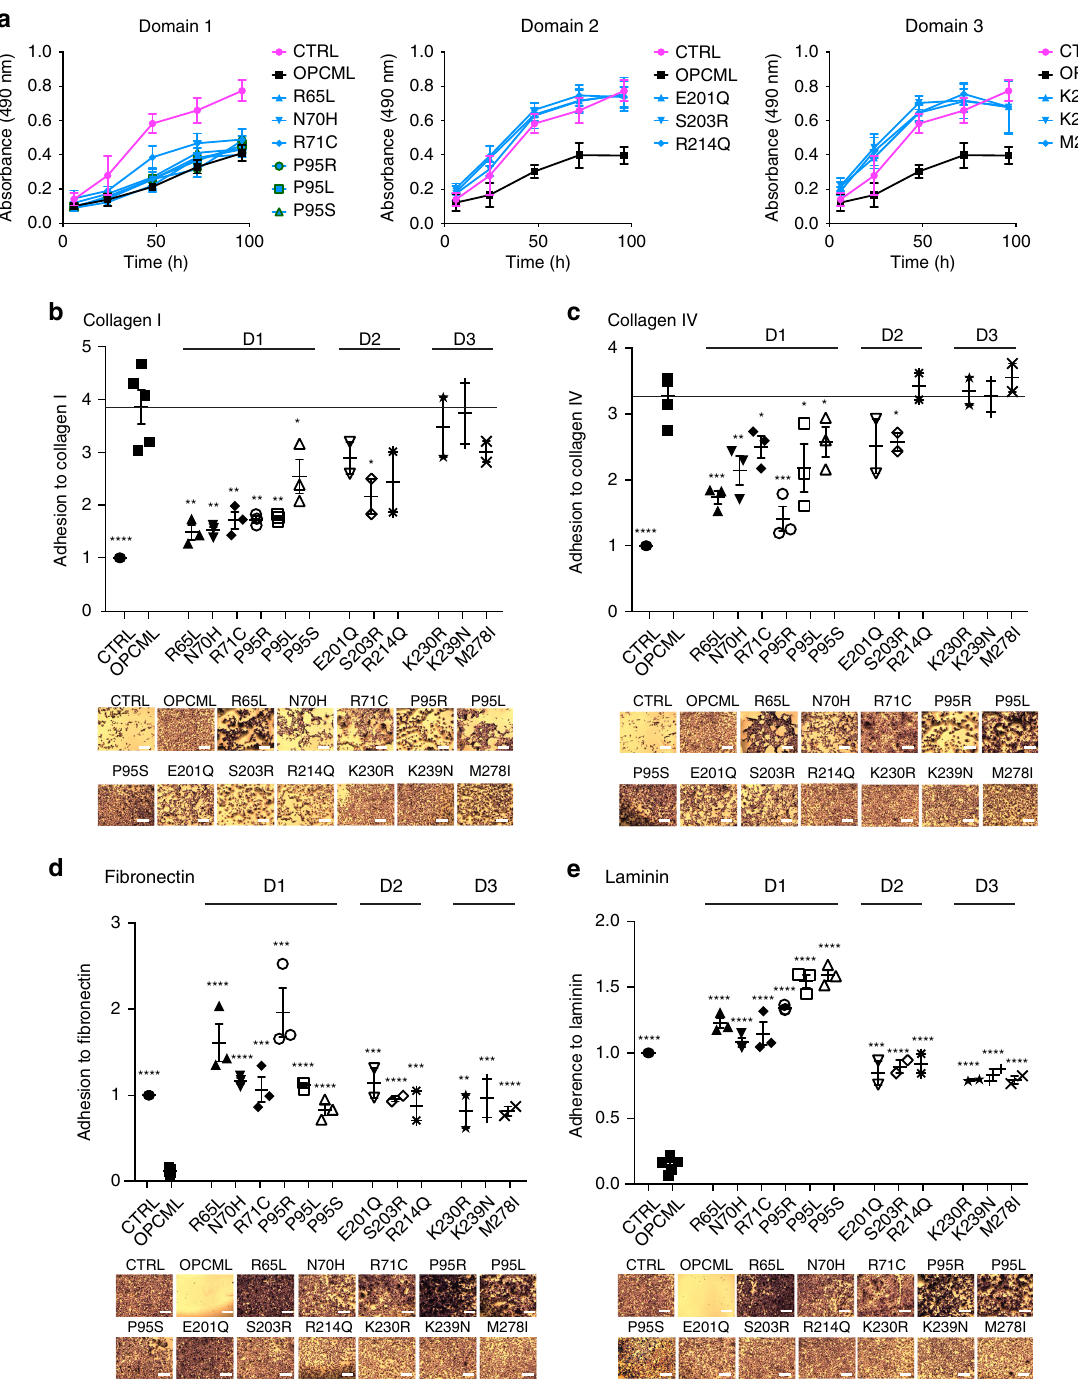
Fig. 7 Different domains mediate distinct functions. a SKOV3 cells transduced with an empty vector (CTRL), wild-type (OPCML) or mutant (R65L, N70H, R71C, P95R, P95L, P95S in D1 in the left panel, E201Q, S203R, R214Q in D2 in the central panel, K230R, K239N, M278I in D3 in the right panel) OPCML were analyzed for proliferation. CTRL cells are represented in magenta, wild-type OPCML in black and the mutants in light blue. All the graphs show the mean ± s.d. of four independent experiments. b – e The different cell lines were plated onto collagen I ( b ), collagen IV ( c ), fi bronectin ( d ) or laminin ( e ), and adhesion was tested after 1 h. Values have been normalized to CTRL. Scale bar = 50 μ m. All the graphs show the mean ± s.e.m. of three independent experiments for domains 1 and 2 independent experiments for domains 2 and 3. Student t -test compares CTRL and mutants to wild-type OPCML: * p < 0.05, ** p < 0.01, *** p < 0.001, **** p <